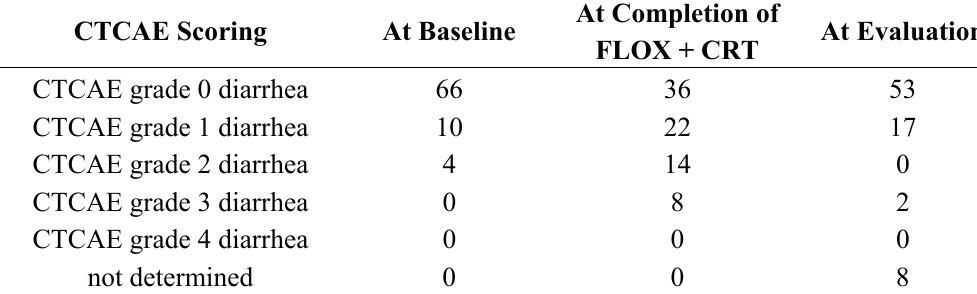
Table 1. Locally Advanced Rectal Cancer—Radiation Response Prediction: the number of study patients (in whom multiplex cytokine profiling of serial serum samples was undertaken; n = 80) reporting diarrhea, graded according to the Common Terminology Criteria for Adverse Events (CTCAE), at the time of diagnosis (baseline), following the course of neoadjuvant treatment with the Nordic FLOX regimen and chemoradiotherapy (CRT), and at evaluation prior to tumor